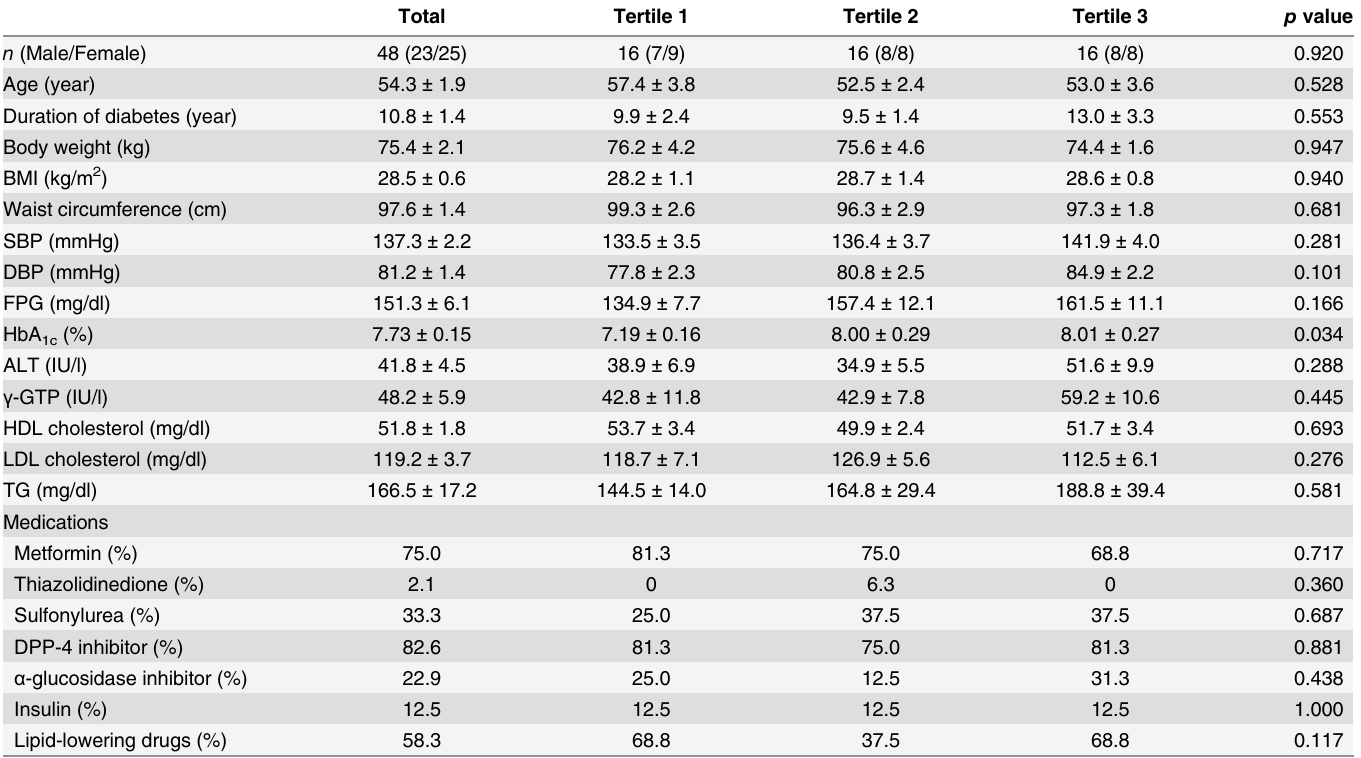
Table 2. Baseline characteristics of the patients with